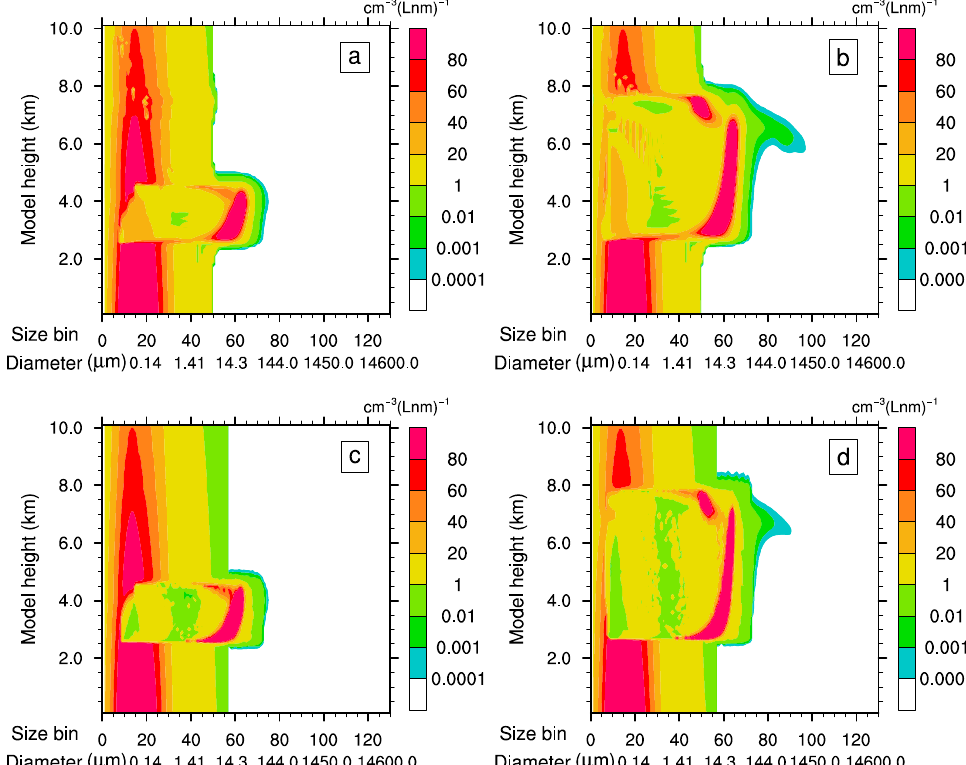
Figure 4. Number distributions of ammonium sulfate aerosol particles and water droplets as a function of height, the natural logarithm of the water mass of the bin, and the natural logarithm of the aerosol mass of the bin f ( Lnm water , Lnm aerosol , Z )( Number cm − 3 ( Lnm water ) at 35 min ( a , c ) and 52.5 min ( b , d ) with the Eulerian advection scheme ( a , b ) and with the Lagrangian advection scheme ( c , d